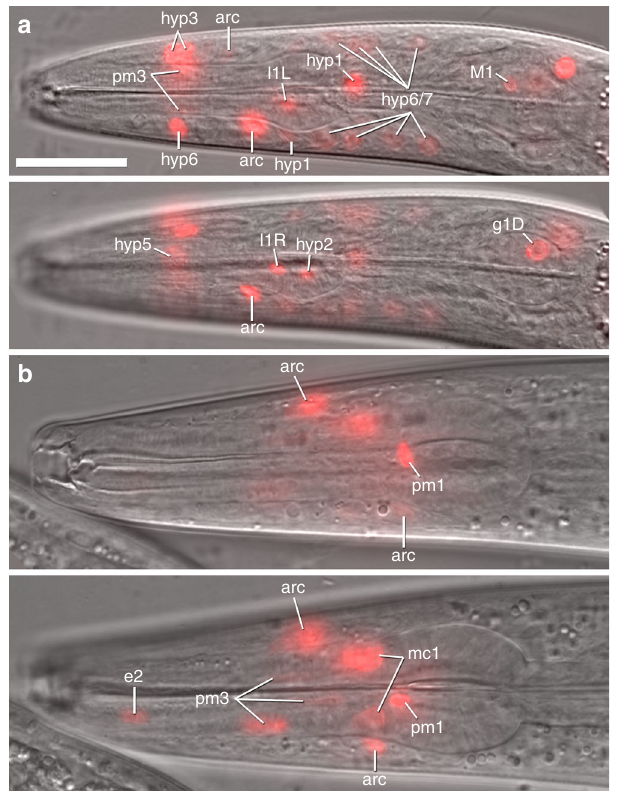
Fig. 3 Spatial expression of seud-1 in Pristionchus paci fi cus . Expression of a nucleus-localised seud-1 promoter ::TurboRFP reporter is shown for ( a ) a J3 larva and for ( b ) a stenostomatous adult hermaphrodite shortly after the fi nal moult, each in two focal planes. J3 is shown in sagittal and left of sagittal planes; adult, in sagittal and right of sagittal planes. Expression is reported for pharyngeal myoepithelial (pm1, pm3, pm4), epithelial (e2, mc1), dorsal gland (g1D), tooth cell-innervating neurons (I1, M1), interfacial (posterior and anterior arcade, “ arc ” ), and anterior epidermal (hyp) cells of, collectively, the anterior pharynx, stoma (mouth), and anterior body wall. Not all expressing cells, some of which (e.g., hyp, arcade cells) could not reliably assigned to a syncytium, are labelled. Expression ontogeny across life-stages suggests variation in timing among various components of dimorphic mouth morphologies, although expression consistently encompassed the breadth of morphology described or, in the case of pharyngeal neurons, presumed to be dimorphic in P. paci fi cus . Scale bar (for all images), 20 µ